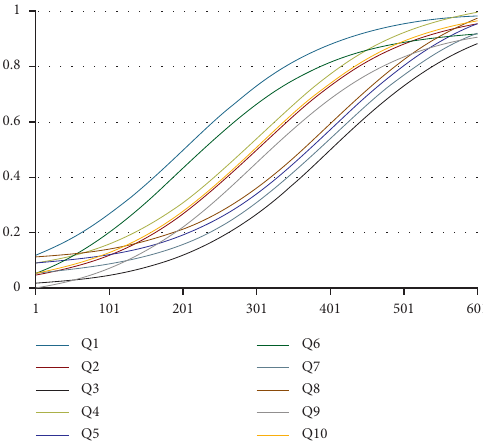
Figure 3: Item characteristic